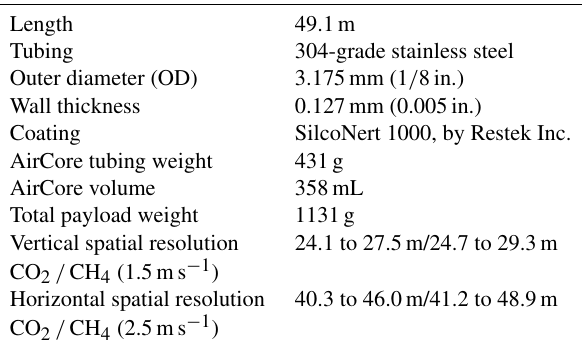
Table 1. The dimensions and key parameters of the active